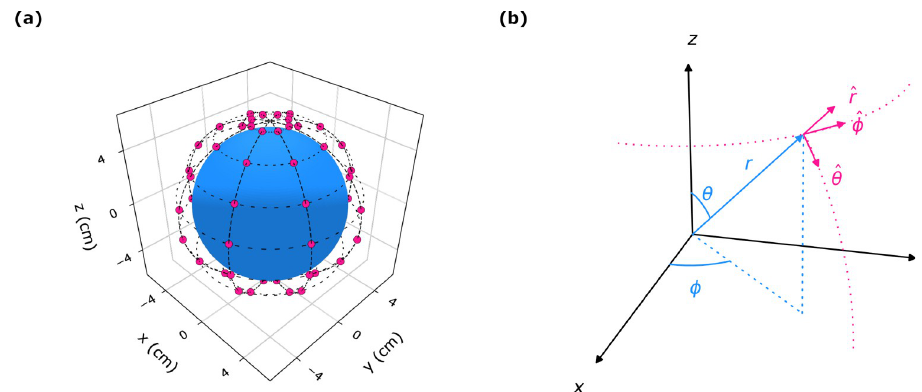
Fig 4. (a) Multiple magnetic dipoles located at 1 cm away from the brain material. The shape in the array of 64 dipoles is a sphere with radius 6 cm around a brain of 5 cm radius. Red circles and blue sphere represent the dipoles and a brain material.